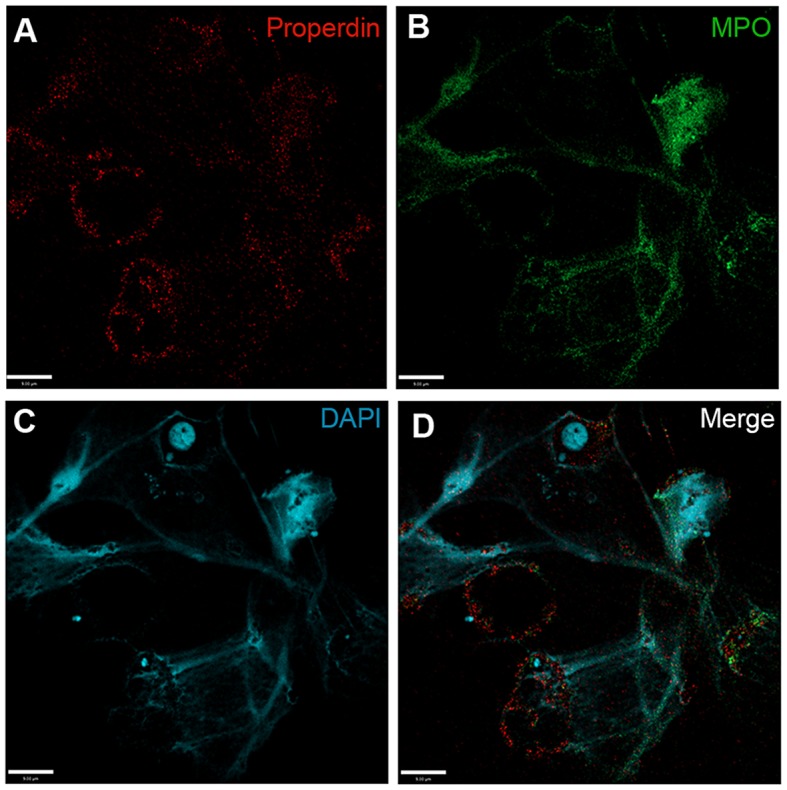
Complement factor P deposits on PMA-induced NETs. Spinning-disk immunofluorescence microscopy images show that (A) complement proteins, e.g., CFP (red), are found to associate with cell body, and NETs induced by PMA. NETs were visualized using (B) an anti-MPO antibody (green) and (C) DAPI stain for DNA (blue). (D) Merged image shows relative locations of proteins on cell body and NETs. Images were taken using a 60×/1.35 oil immersion objective. Scale bar, 9.00 μm.